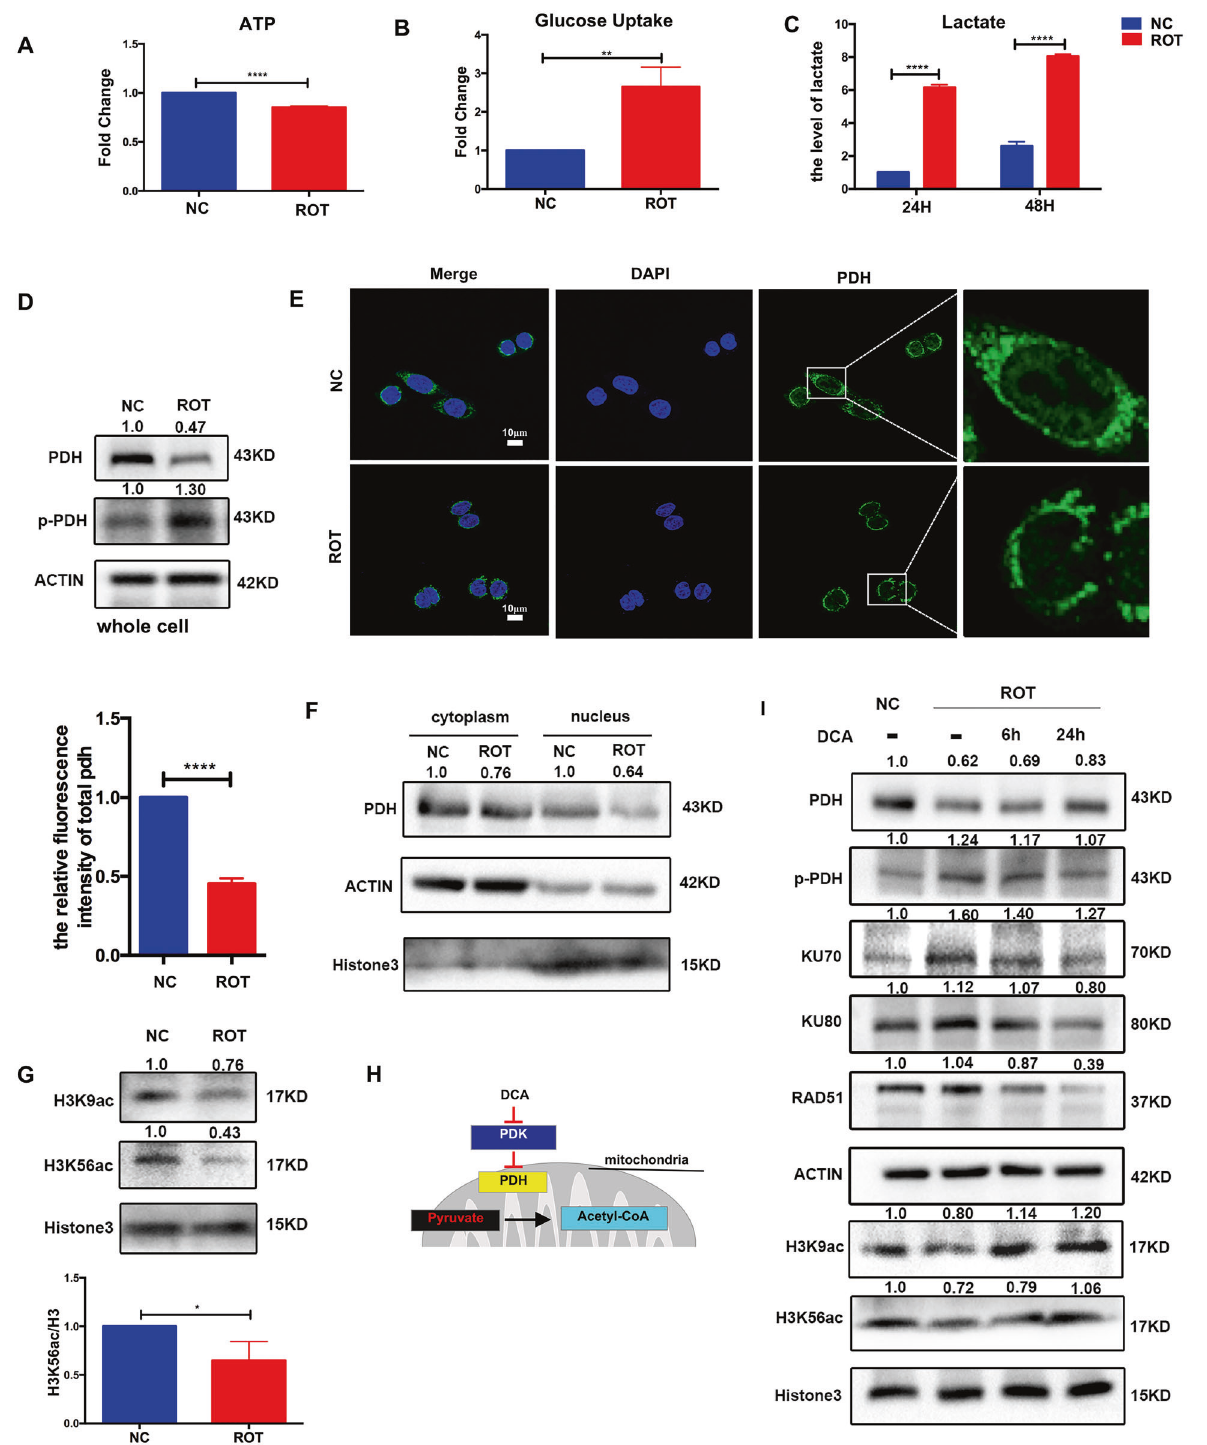
Fig. 3 Downregulation of PDH in complex I de fi cient cells contributed to glycolysis and DDR. A – C Complex I de fi cient cells showed decreased ATP level ( A ) and increased glucose uptake ( B ), lactate secretion ( C ) compared with that in control cells. ( n = 3), ** P < 0.01, ****P < 0.0001. D Levels of PDH and p-PDH protein in NC and ROT cells. E Confocal photography showed the levels of PDH (green) and DAPI (blue) in the cytoplasm and nucleus in NC and ROT cells. Magni fi ed areas taken at ×5 magni fi cation, scale bar: 10 μ m. Relative fl uorescence intensity was shown. ( n = 5), **** P < 0.0001. F Study of PDH expression in extracted nucleus and cytoplasm of NC and ROT cells by western blot. G Levels of H3K9ac and H3k56ac protein in NC and ROT cells, Relative protein levels of H3K56ac were normalized to H3 ( n = 3), * P < 0.05. H Mechanism for DCA-mediated increase in histone acetylation. I Western blot analysis of PDH, H3K9ac, H3k56ac, DNA repair protein in NC cells and ROT cells with or without DCA (5 mM) for 6 h and 24 h in ROT group. Data are presented as the means ±